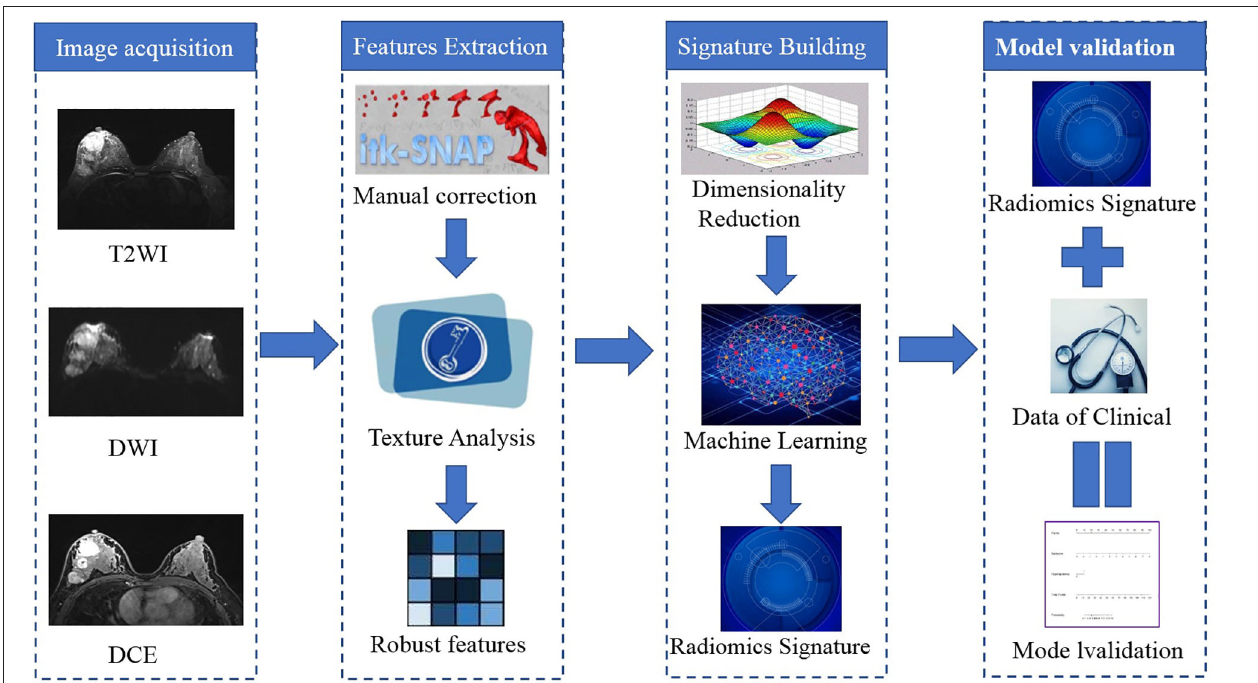
FIGURE 2 | Workflow for building the radiomics signature and creating the model. T2WI, T2-weighted image; DWI, diffusion-weighted imaging; DCE, dynamic contrast enhancement.